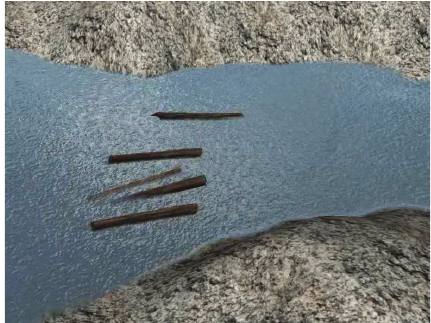
Figure 9: Since the vertical extents of blockers are taken into account, water can also flow below objects. Figure 10: Logs floating on a river.